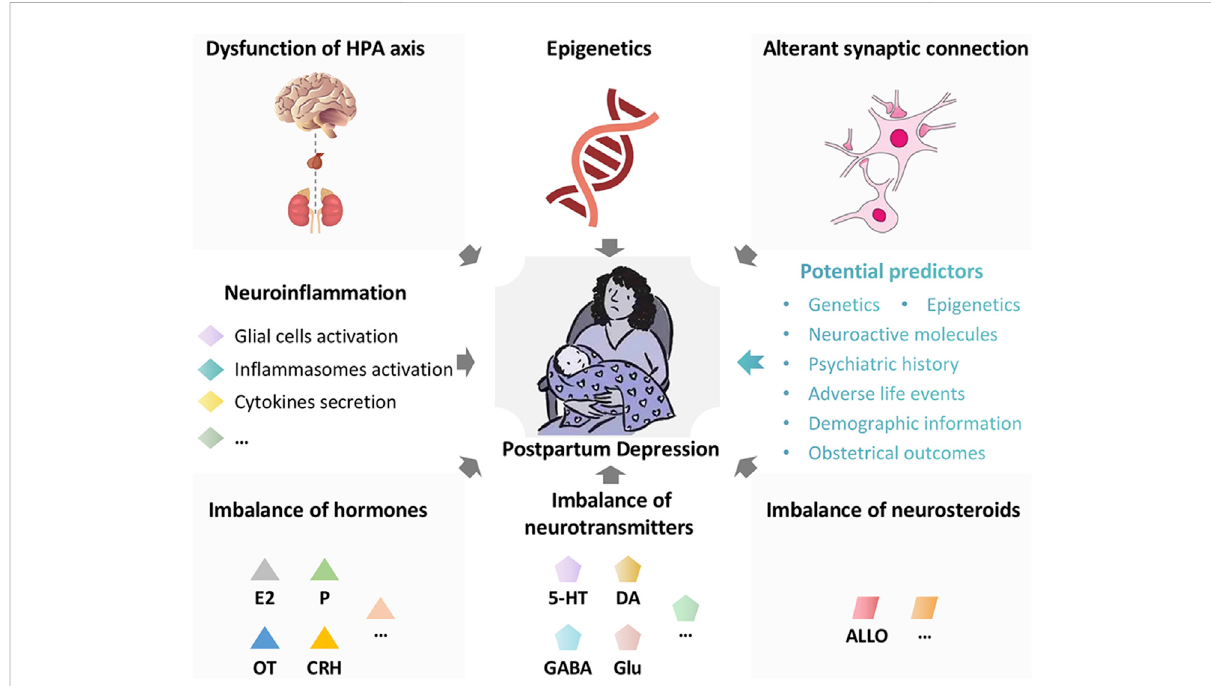
FIGURE 1 The potential pathogenesises and predictors in postpartum depression. The potential pathogenesises in postpartum depression are multiple and as follows: Dysfunction of hypothalamic-pituitary-adrenal (HPA) axis, imbalance of hormones (estradiol, progesterone, oxytocin, corticotropin releasing hormone, etc.), imbalance of neurotransmitters (serotonin, dopamine, γ -aminobutyric acid, glutamate, etc.), imbalance of neurosteroids (allopregnanolone, etc.), epigenetics, alterant synaptic connection, neuroin fl ammation, and so on. The potential predictors for postpartum depressionareasfollows:genetics,epigenetics,neuroactivemolecules(allopregnanolone, β -endorphin,cortisol,corticotropin-releasinghormone, oxytocin, thyroid function, in fl ammatory markers, etc.), psychiatric history, adverse life events, demographic information (maternal age, race, socioeconomic status, etc.), and obstetrical outcomes (preterm birth, etc.). HPA axis, hypothalamic-pituitary-adrenal axis; E2, estradiol; P, progesterone; OT, oxytocin; CRH, corticotropin releasing hormone; 5-HT, serotonin; DA, dopamine; GABA, γ -aminobutyric acid; Glu, glutamate; ALLO,